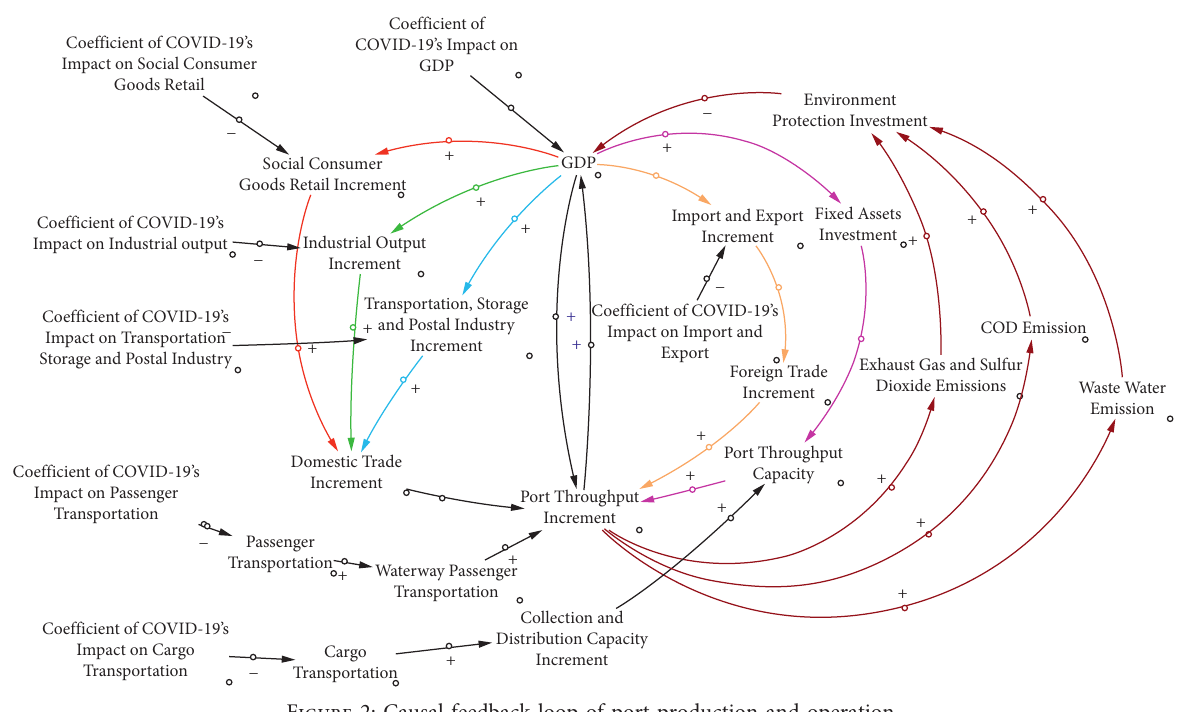
Figure 2: Causal feedback loop of port production and operation. Table 1: Variables in the flow